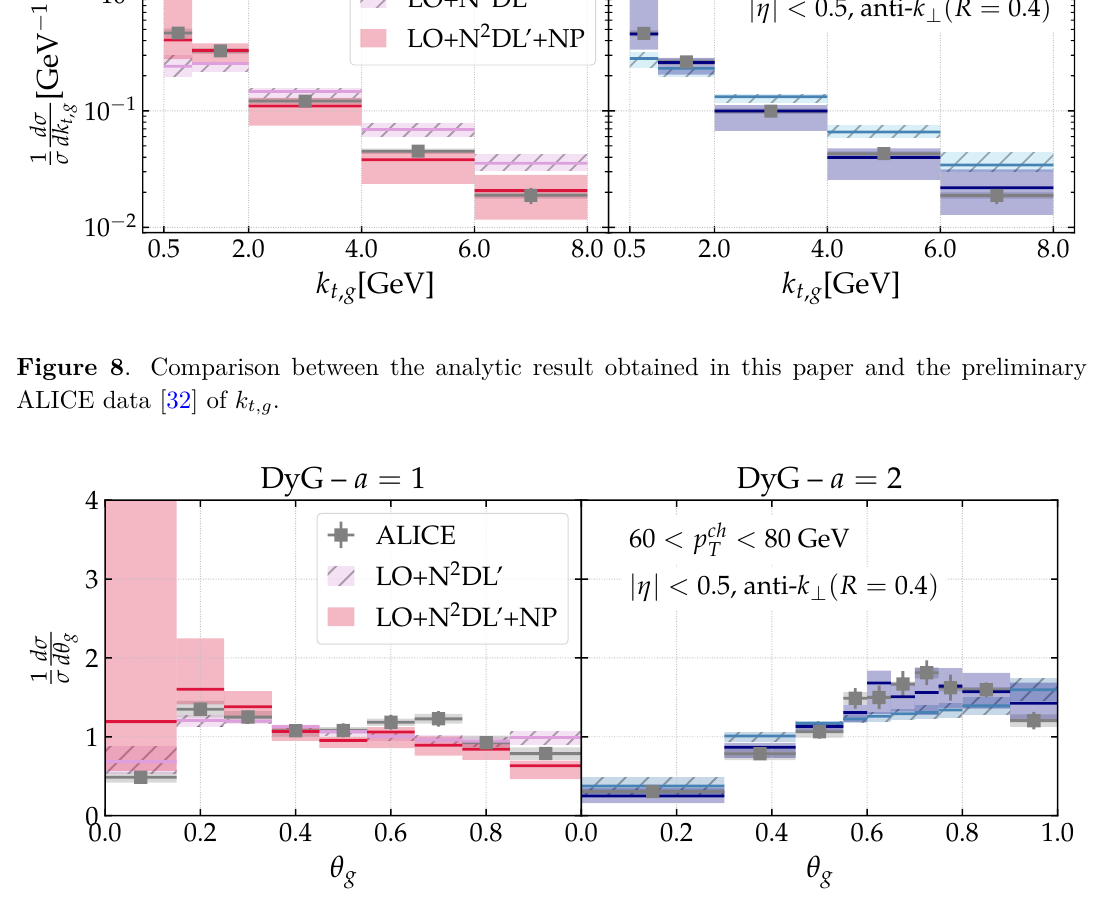
Figure 9 . Same as figure 8 for θ g . The experimental data was obtained from